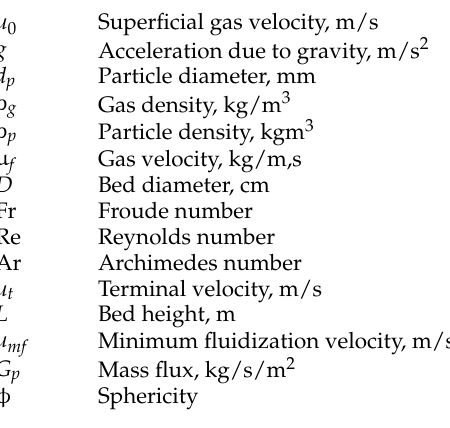
Figure 11. Predicted pressure drop vs. experimental data ( 𝑑 𝑝 = 3.18 mm , ρ 𝑝 = 950 kg/m 3 ).